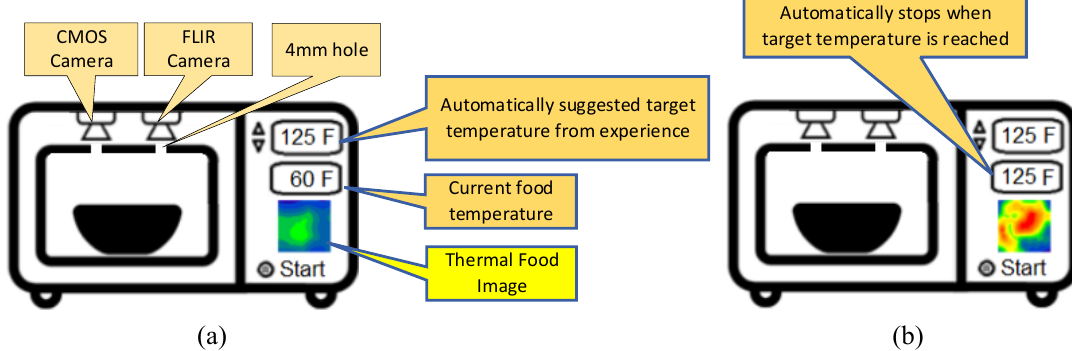
Figure 1. The proposed system’s overall operation. ( a ) After the food is put in and the door is closed, the proposed microwave takes an image and recommends the target food temperature using deep learning-based image classifier; ( b ) When the “Start” button is pressed, the microwave starts heating the food and automatically stops heating when food temperature reaches the target temperature. On a graphical liquid crystal display (LCD), the thermal image of the food is shown in real-time. The two cameras are placed at the outside of the oven cavity, on the cavity’s roof, where the cameras can sense the light and the heat through two small 4-mm holes.